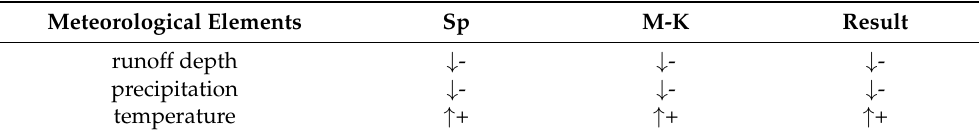
Table 3. Detected variation trends of meteorological elements in Chabagou River Watershed. Sp = Spearman’s rank correlation coefficient; M-K = Mann-Kendall